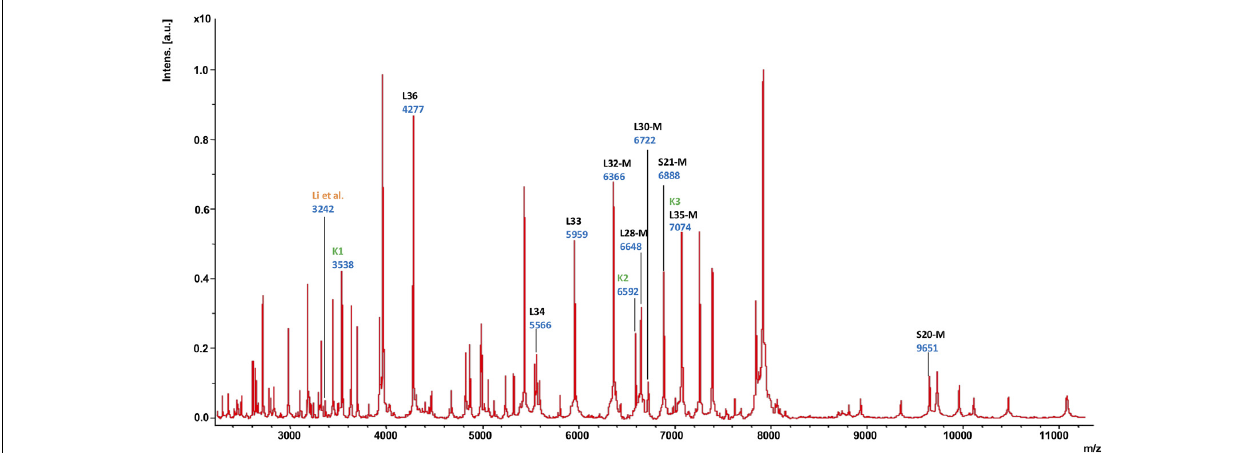
FIGURE 2 | MALDI-TOF mass spectrum of C. difficile reference strain 630 (= DSM 27543). In this mass spectrum, all singularly charged biomarkers that were included in the C. difficile proteotyping scheme are marked in black; multiply charged ions are not labeled separately. Additionally, the biomarkers used for C. difficile subtyping by Li et al. (2018) as well as Kuo et al. (2015) are indicated in orange (“Li”) dark and green (“K1”, “K2”, “K3”),